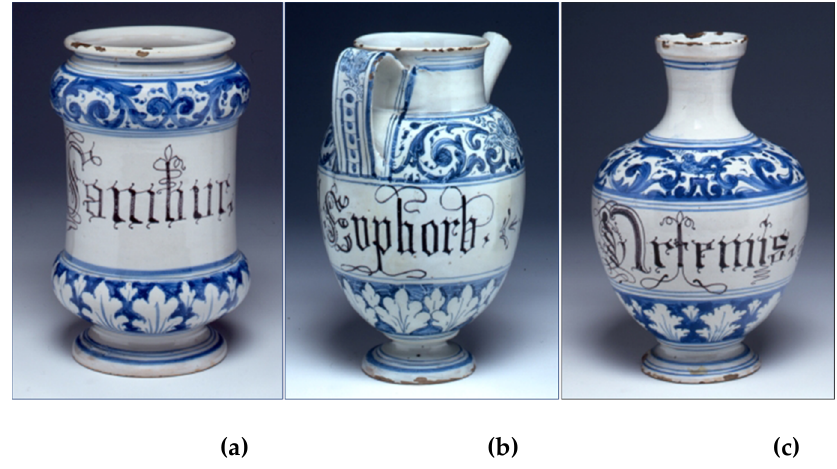
Figure 1. Majolica vases: ( a ) spool albarello ; ( b ) orciolo ; ( c ) spheroidal bottle. (Images owned by Fondazione IRCCS Ca’ Granda Ospedale Maggiore Policlinico , Milan.) In some cases, the abbreviations were hard to interpret also due to potential spelling mistakes made by the decorator, or to the presence of uncommon and unfamiliar words. As a way of example, we cite vase n. 33, Syrupus d. Duab. Rad ., which was the extremely contracted version of the Latin Syrupus de Duabus Radicibus . For these reasons, the inscrip- tions needed attentive reading. Based on the interpretation of the labels and the origin of the main ingredients, the jars were further categorised as plant-based (108 vases; vase n. 17, which contained as the main ingredient mushrooms belonging to the genus Agaricus, was also included in this category), animal-based (13), mineral-based (8), or unknown origin (21; in these cases, both the deciphering of the inscriptions and the historical survey yielded no usable results). Finally, the plant-based category was subdivided into 15 groups, based on the type of preparation: aqua (27 vases; aqueous extract); syrupus (21; syrup); trochiscus (18; dosage form similar to granules); oleum (12; oleolytes); unguentum (9; ointment); electuarium (6; electuary); pilulae (5; dosage form similar to tablets); mel. ros (2; honey-based composition); pulvis (2; powder); reb/roab (2; condensed syrup); oxymel (2; liquid preparation based on honey and vinegar); diatrum (1; preparation made up of three components); emplastrum (1; poultice); floris (1; flowers); opiatus poter. (1; opium-based preparation). It is worth recalling that the remaining jars represent only a limited part of all the products that could originally be found in the Pharmacy, thus giving us only partial knowledge concerning the remedies used. See Table 1 for details. Table 1. List of the 108 plant-based vases, with information about vase number (corresponding to the cataloguing number attributed to each vase in the collection preserved at the Service for Cultural Assets of the Policlinico of Milan), original vase inscription, plant ingredients present in the remedy with the indications of the scientific names, and the historical source. Plant Ingredients (Genus/Species)